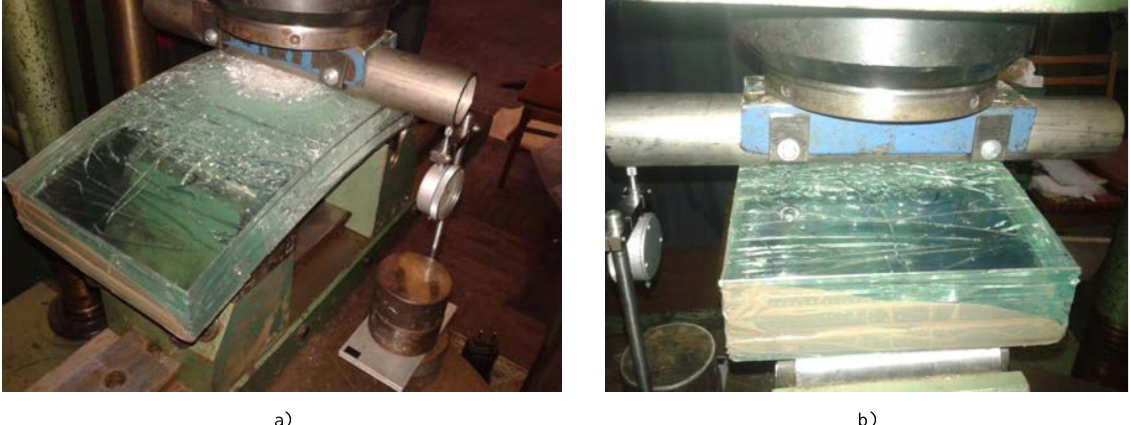
Fig. 7 Three-point bending tests of the bulletproof glass specimen damaged by a single ballistic impact : the position of the loading device on the impact region a) at a distance from the impact region. Two different laminated structures were